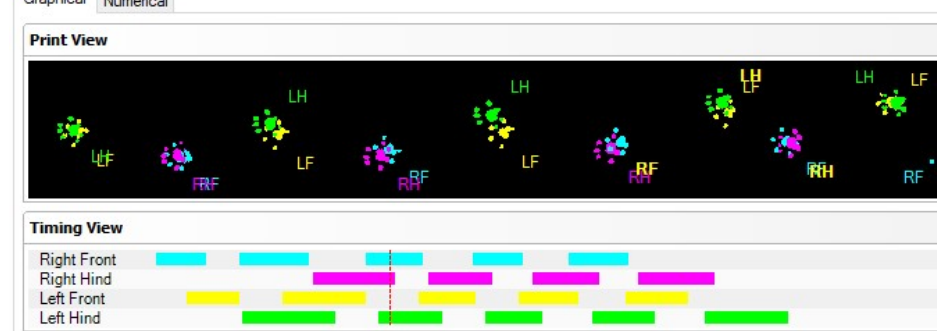
Figure 2. Primary data registered using CW system in normal speed passing of a Wistar rat. Upper panel depicts the paw imprints for each definition of right (R) and left (L) paw, and front (F) and hind (H) paw. Lower panel depicts the numerical automated registration after the paws are defined.